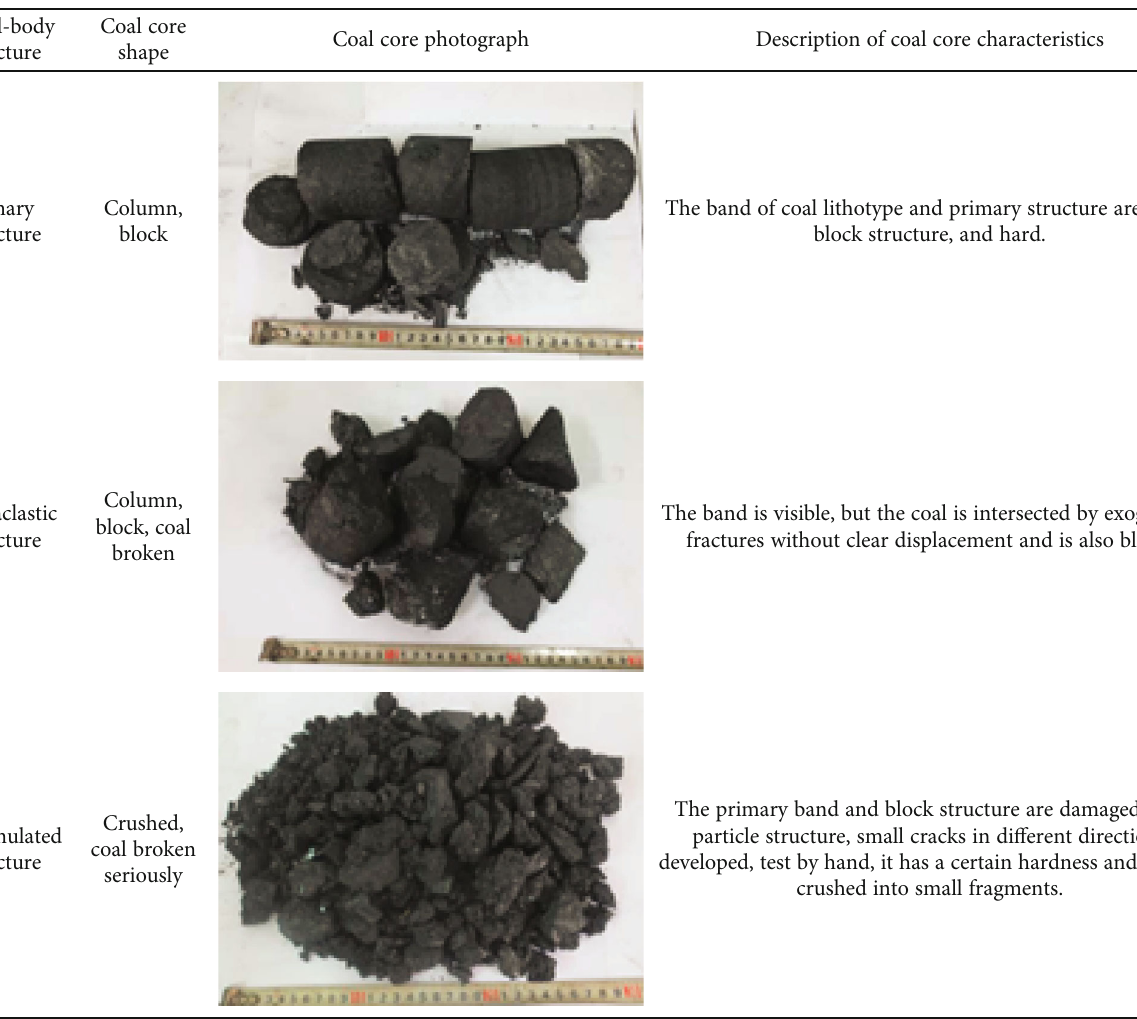
Table 1: Coal-body structure division of a coal seam in the Mabidong block (refer to reference [21]). Coal-body Coal core photograph Description of coal core characteristics structure shape